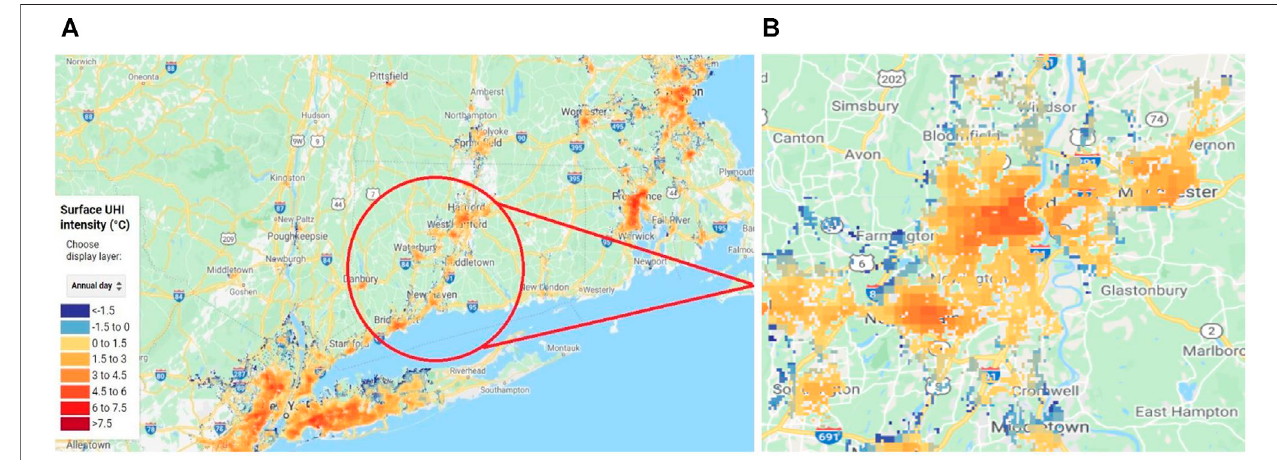
FIGURE1 | Areasatellite illustrations highlighting the impacts of UHIand surfacetemperatures inthe United States (A) and Hartford region, Connecticut (A) . (B) — Adapted from Climate Central, 2014.